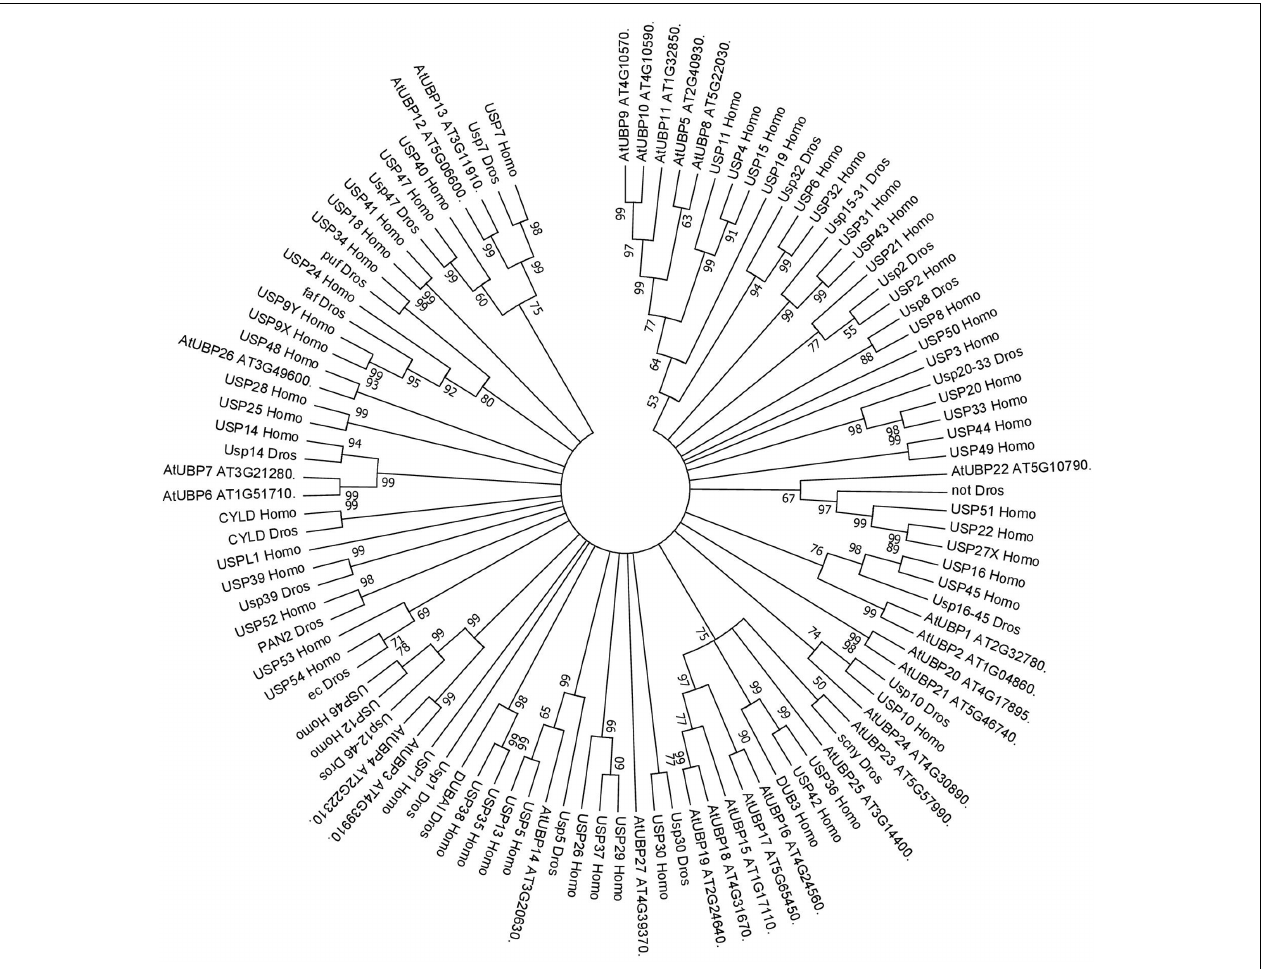
FIGURE 2 | Consensus phylogenetic tree of UBPs/USPs. The tree shows phylogenetic conservation of proteins from Arabidopsis, Drosophila, and humans. The analysis was conducted in MEGA7 (Kumar et al., 2016). The tree was constructed by the Neighbor-Joining method with bootstrap resampling (5000 replicates). The numbers in the nodes indicate bootstrap values. The distances were computed using the Poisson method. Scale bars indicate units of the number of amino acid substitutions per